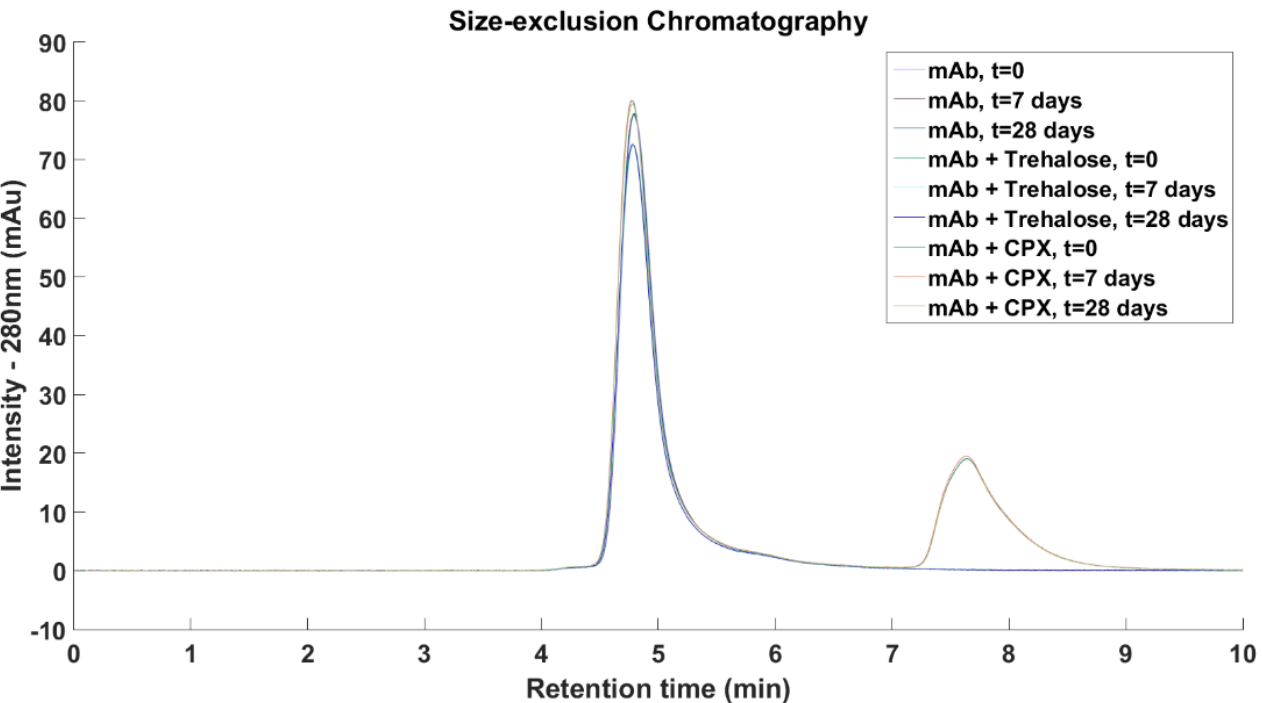
Figure 9. mAb1 and Compound X were eluted after 4.8 min and after 7.6 min, respectively. Only a single antibody peak was seen in all tested samples with no higher molecular weight aggregates were detected as well as the intensity and integrity of the mAb1 peaks were maintained over the observed period, suggesting mAb1 stable at 50 °C at 1 mg/mL over 28 days. Neither Compound X nor trehalose destabilise mAb1.